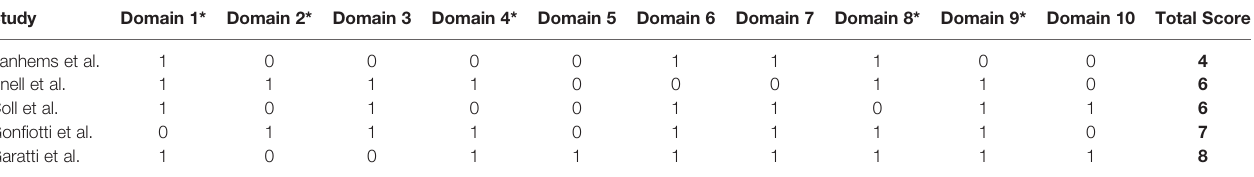
TABLE 4 | Risk of bias assessment - case series (n = 5). Study